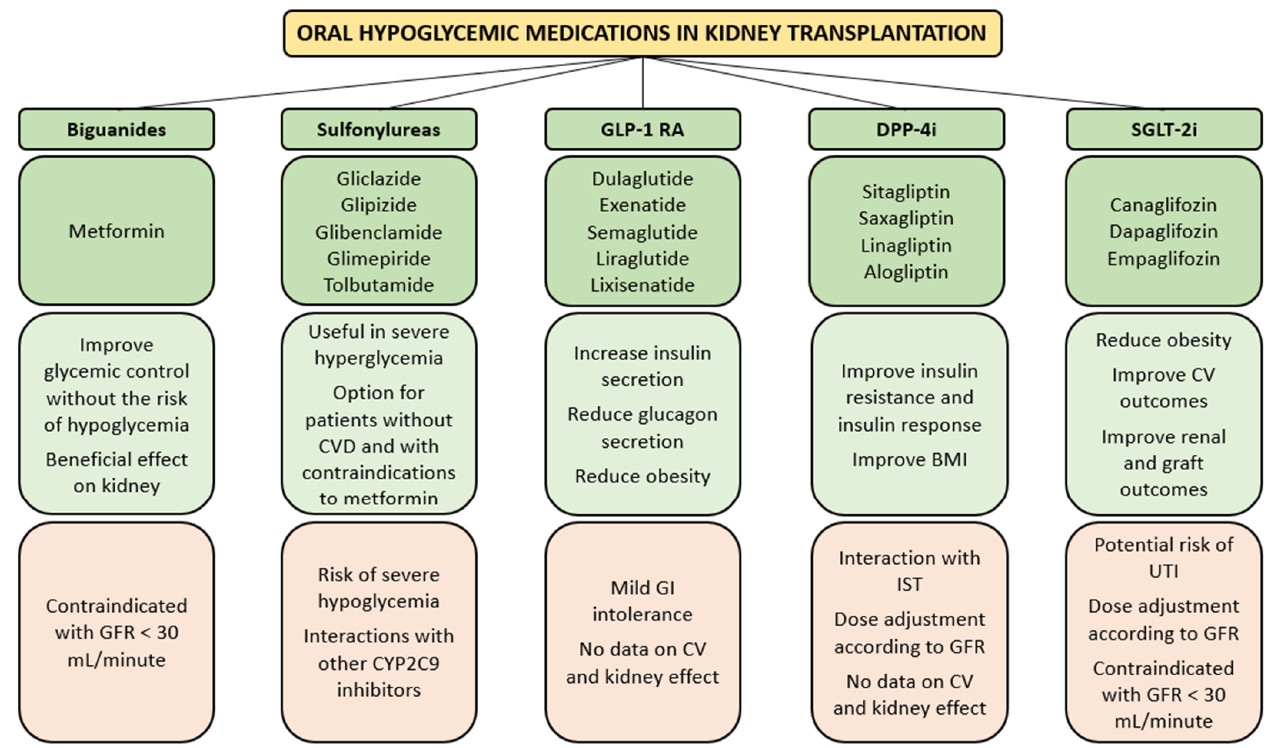
Figure 2. Most frequently used oral hypoglycemic medications (dark green) in kidney transplantation, with the main advantages (light green) and concerns (light orange). BMI, body mass index; CV, cardiovascular; CVD, cardiovascular disease; CYP2C9, cytochrome P450 family 2 subfamily C member 9; GFR, glomerular filtration rate; GI, gastrointestinal; DPP-4i, dipeptidyl peptidase-4 inhibitors GLP-1 RA, glucagon-like peptide-1 receptor agonists; IST, immunosuppressive therapy; SGLT-2i, sodium glucose cotransporter-2 inhibitors.